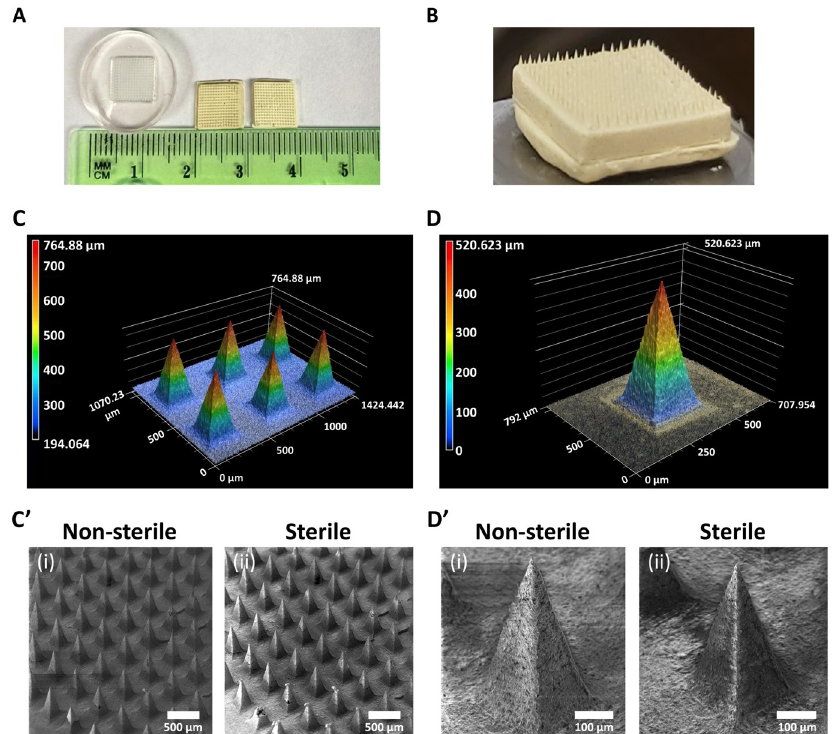
Fig 3. Microscopy characterizations demonstrated that microneedles with high concentration of drug are uniformly organized on the patch surface and preserve their morphological properties after the sterilization process using ethylene oxide gas. Macroscopy view. A) PDMS mold vs. microneedle patches. B) Zoom of microneedle patch surface. Microscopy view. C) 3D laser image of microneedle patch. C’) SEM images of non-sterile (i) and sterile (ii) multiple microneedles patch 3D laser image of microneedle patch. The topography of one microneedle. D) 3D laser image of microneedle patch. D’) SEM images of non-sterile (i) and sterile (ii) microneedle